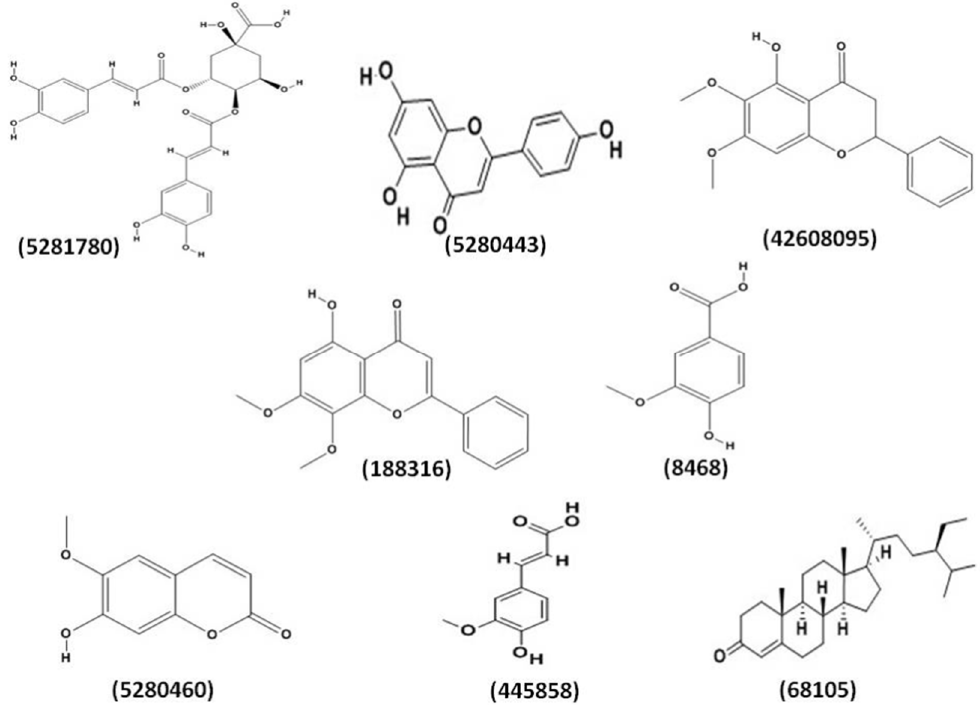
Figure 1. The selected phenolic compounds with their labels from A. paniculata and S. paniculata .